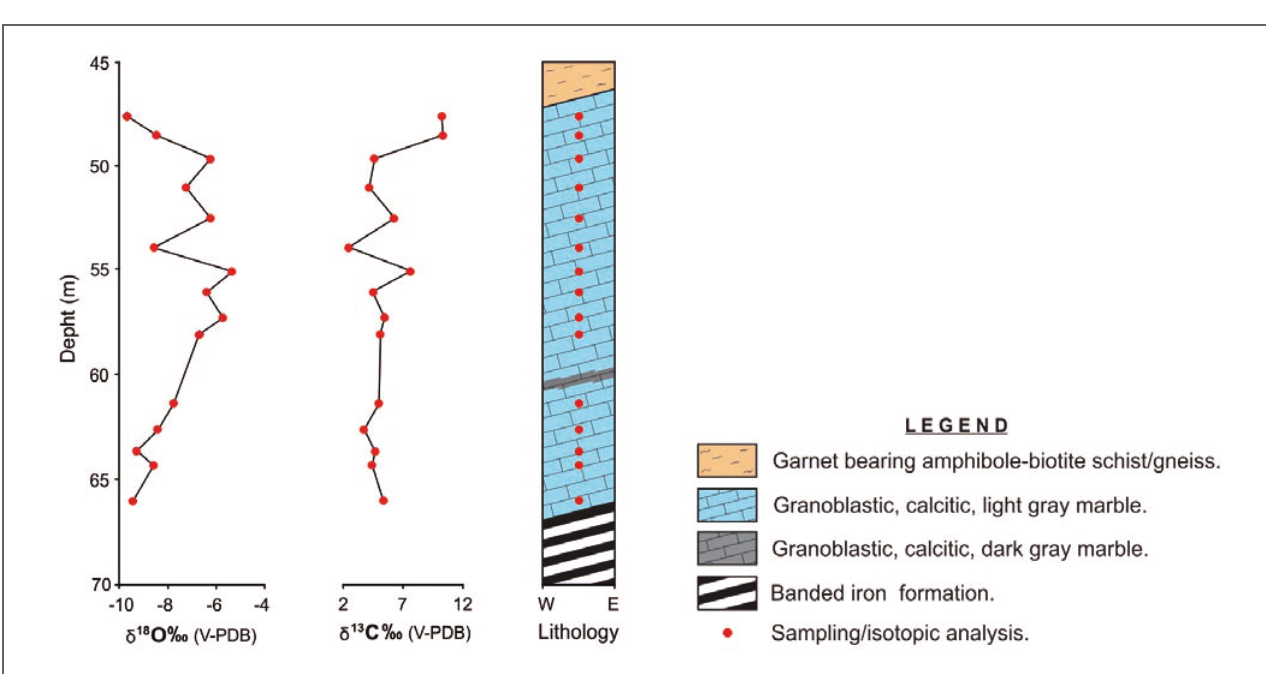
Figure 10 - Isotopic (C and O) chemostratigraphy of the marbles of the Saquinho stratigraphic hole, using data from Table 1.